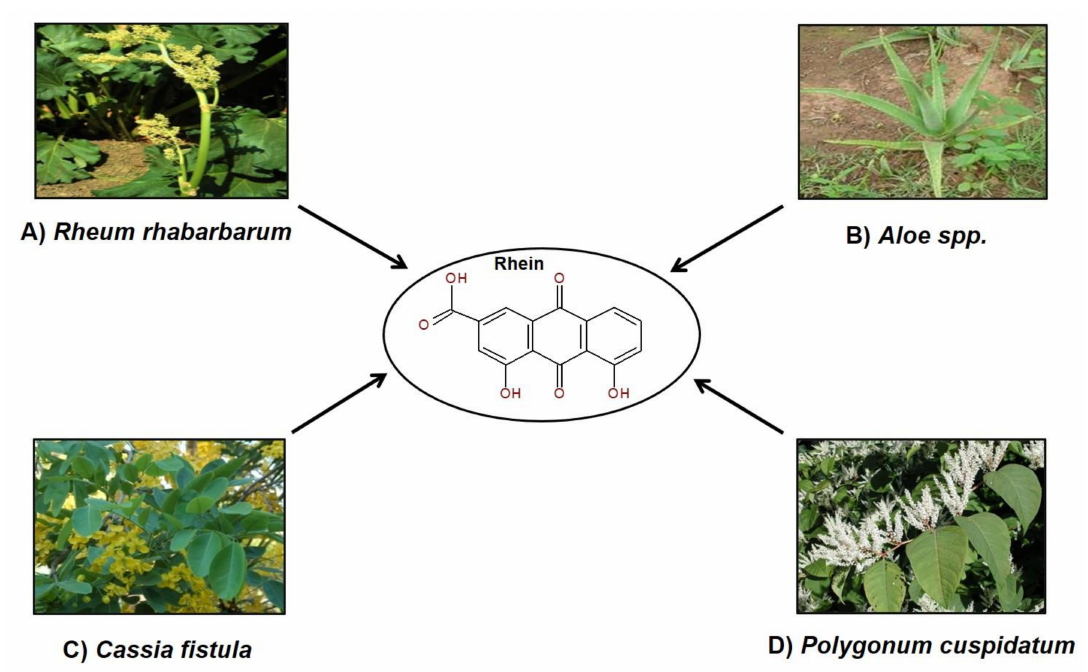
Figure 1. Sources of rhein: ( A ) Rheum rhabarbarum (Kay Yatskievych / www.discoverlife.org); ( B ) Aloe spp. (Pankaj Oudhia / www.discoverlife.org); ( C ) Cassia fistula (John Pickering / www.discoverlife.org); ( D ) Polygonum cuspidatum (Les Mehrho ff/